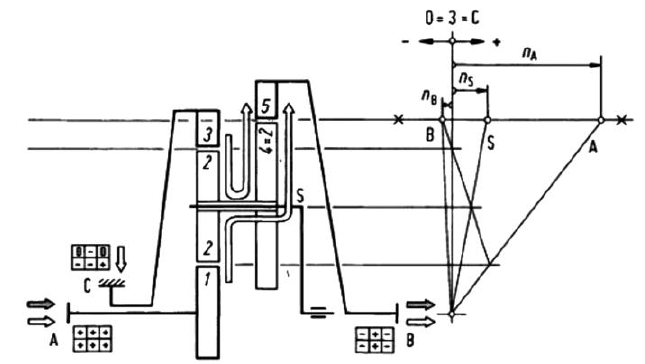
Figure 4. Kinematic scheme of the Wolfrom stage gearbox.